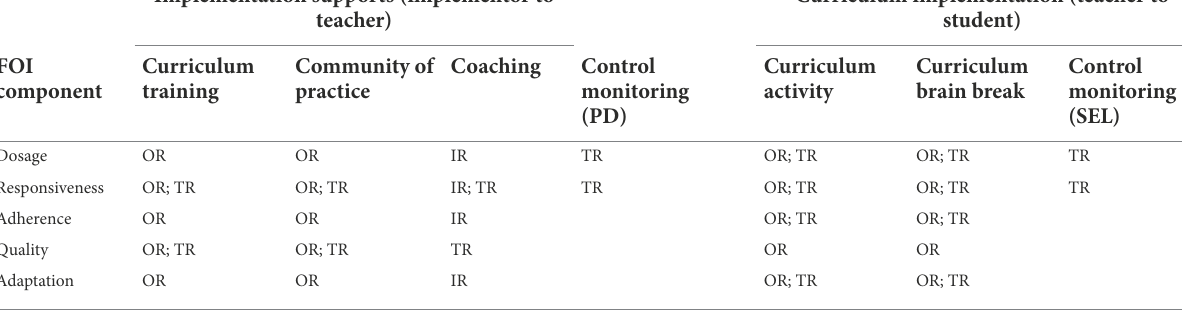
TABLE 2 Example of multi-informant measures of fidelity of implementation components across levels and groups. Implementation supports (implementor to